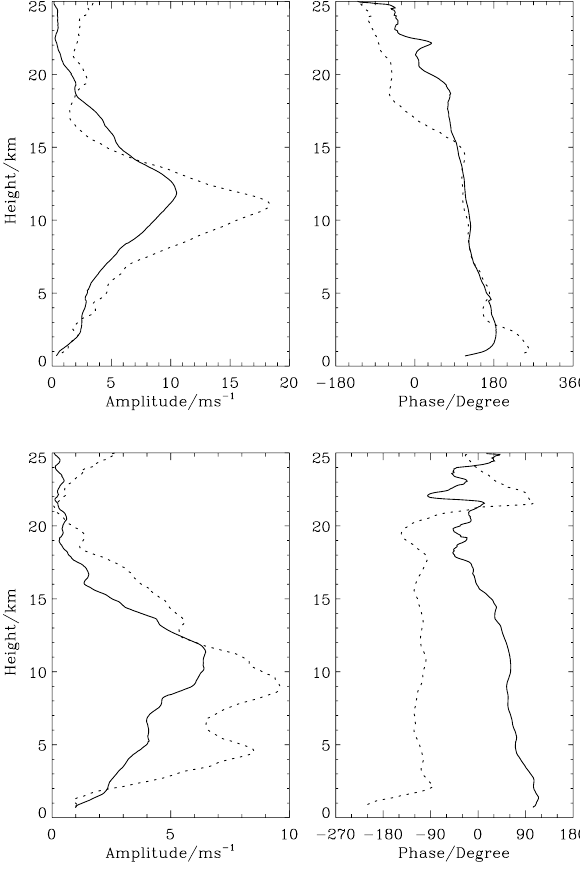
Fig. 14. Similar to Fig. 13, but for